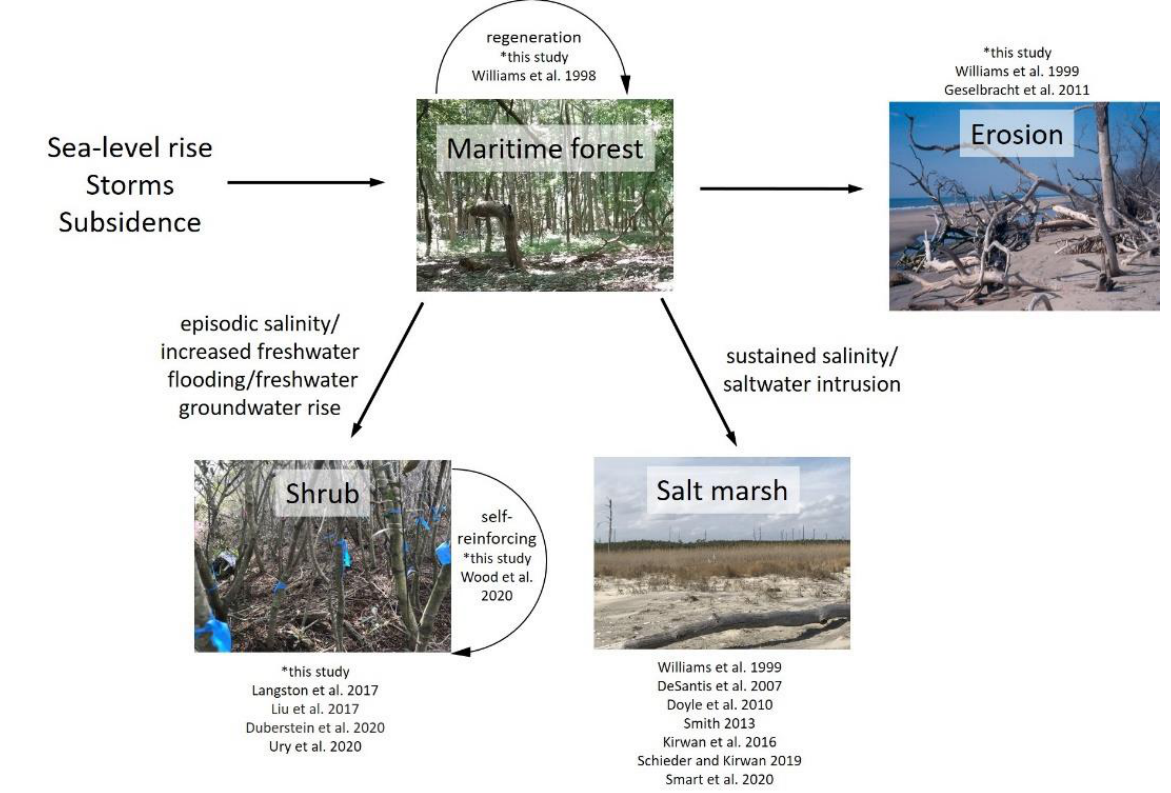
Figure 7. External drivers that alter salinity, sediment, and flooding dynamics in coastal systems lead to alternative pathways for maritime forest. Depending on elevation and geographic position, maritime forest can regenerate if salinity and flooding pressures are not sustained (i.e., after a storm disturbance): it can be converted to salt marsh due to sustained salinity pressure, it can convert to a shrub-dominated stage through increased freshwater flooding/intermittent saline flooding, or it can be directly lost due to coastline erosion. A sustained woody state provides an alternative form of maritime forest